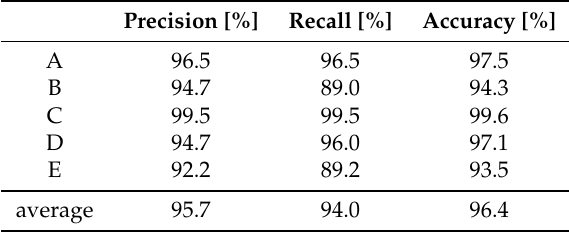
Figure 8. Results of two subjects’ amplitudes. Table 2. Workload recognition results